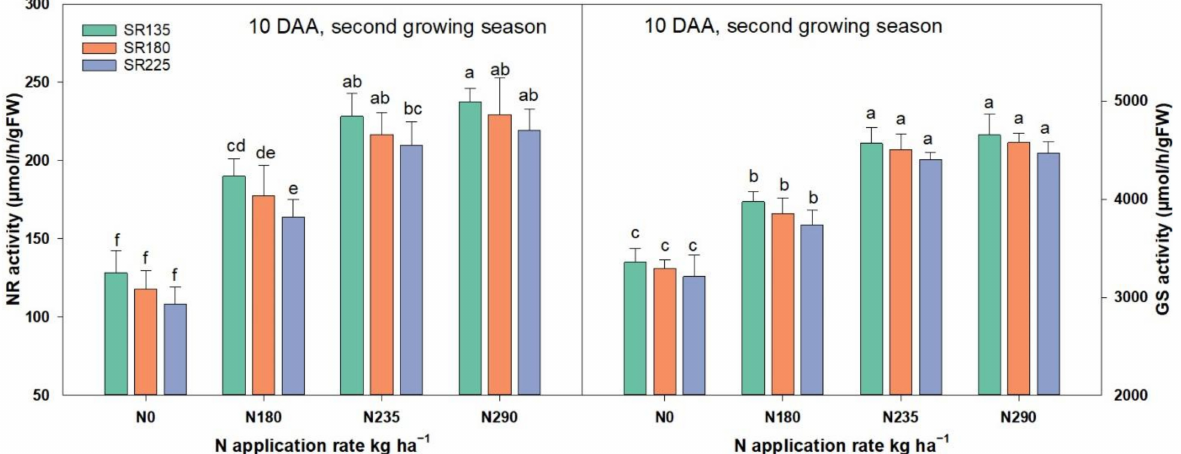
Figure 4. Combination effects of N and SR on nitrate reductase (NR) and glutamine synthesize (GS) activities during four differnet growing stages in 2018–2019. Different letters represent significant differences in mean values of three replicate plots at p ≤ 0.05 levels according to Duncan’s test; * p ≤ 0.05 and ** p ≤ 0.001,